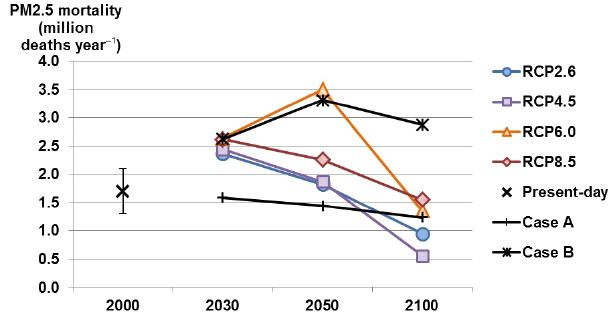
Figure 9. Global burden on mortality of PM 2 . 5 concentrations rel- ative to 1850, in the present day for 2000 concentrations, showing multi-model average and 95% CI including uncertainty in RR and across models (deaths per year), and in 2030, 2050 and 2100 for all RCPs, showing multi-model averages (deaths per year) given by the deterministic values. Also shown are future burdens using (Case A) 2000 concentrations relative to 1850 and present-day population but future baseline mortality rates and (Case B) 2000 concentrations relative to 1850 but future population and baseline mortality